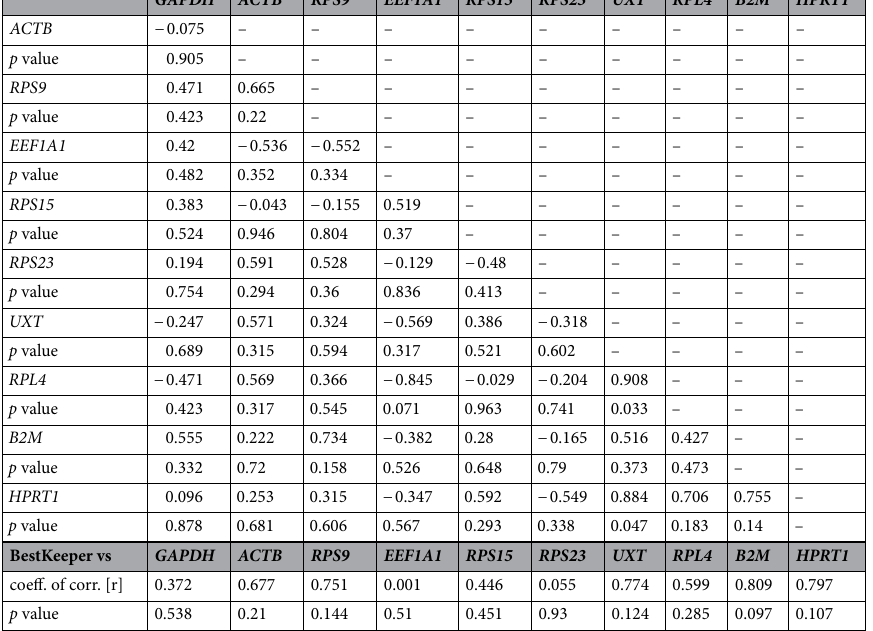
Table 13. Analysis of repeated pair-wise correlation amongst genes in DHC with BestKeeper index.